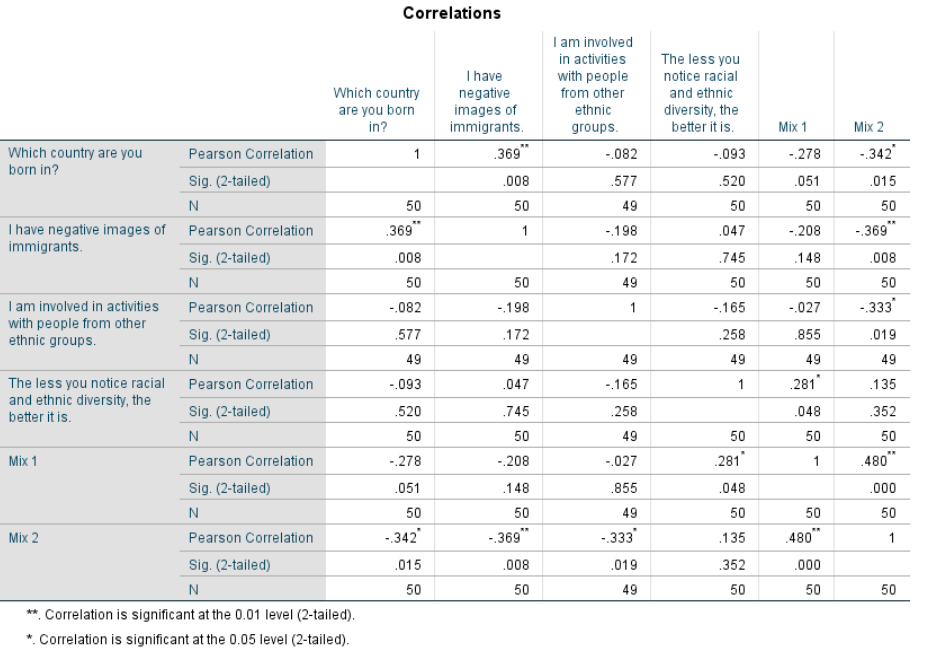
Figure 7. Pearson’s R correlation.